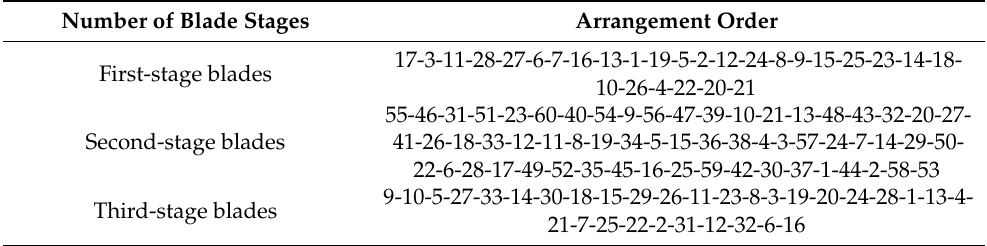
Figure 11. The first-, second-, and third-level blade arrangement diagrams. The sequence table (counterclockwise) of the first-, second-, and third-level blades optimized using reinforcement learning is shown in Table 5. Table 5. First-, second-, and third-level blade arrangement order table.